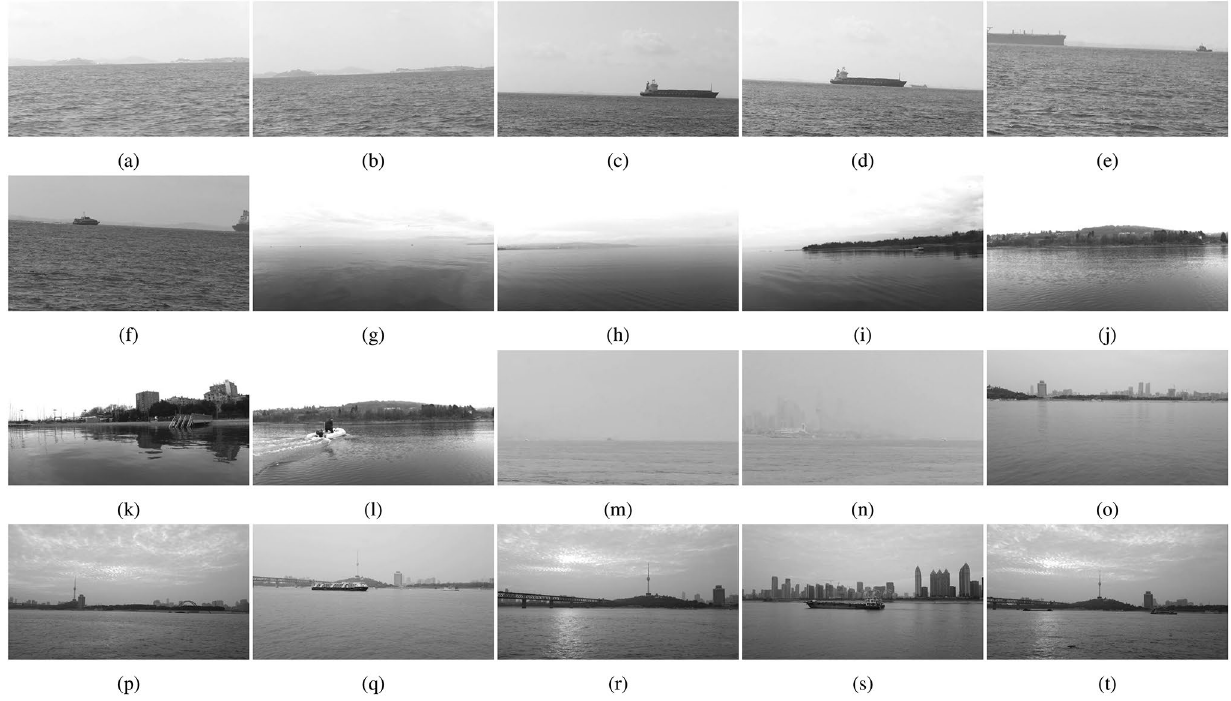
Figure 5. Random navigation scenes from the testing set.